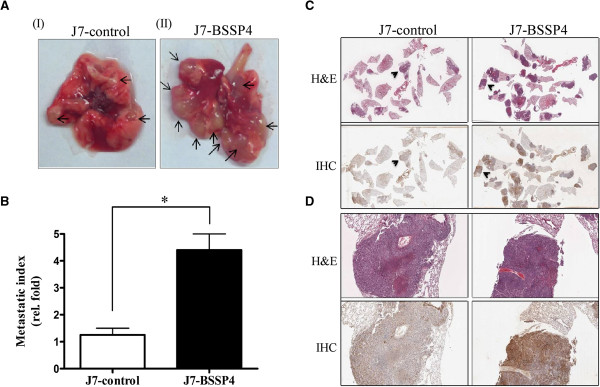
BSSP4 increases cell motility in vivo. The images (A) depict tumor foci of lung sections (arrows indicated) in both J7-control (A, I) and J7-BSSP4 cells (A, II). The metastatic index (fold, density of tumor numbers in per cm2 area) in lung for J7-control and J7-BSSP4 cells is specified (B). Tumor foci and BSSP4 expression of J7-control (C, left panel) and J7-BSSP4 cells (C, right panel) were examined using H & E staining (C, upper panel) or IHC (C, lower panel), respectively. The tumor foci covered almost all areas seen in (D) (C and D represent different magnifications, arrowheads in C are magnified in D). Values are presented as fold increase of J7-BSSP4, relative to J7-control. Differences were analyzed using One-way ANOVA, *P < 0.05.